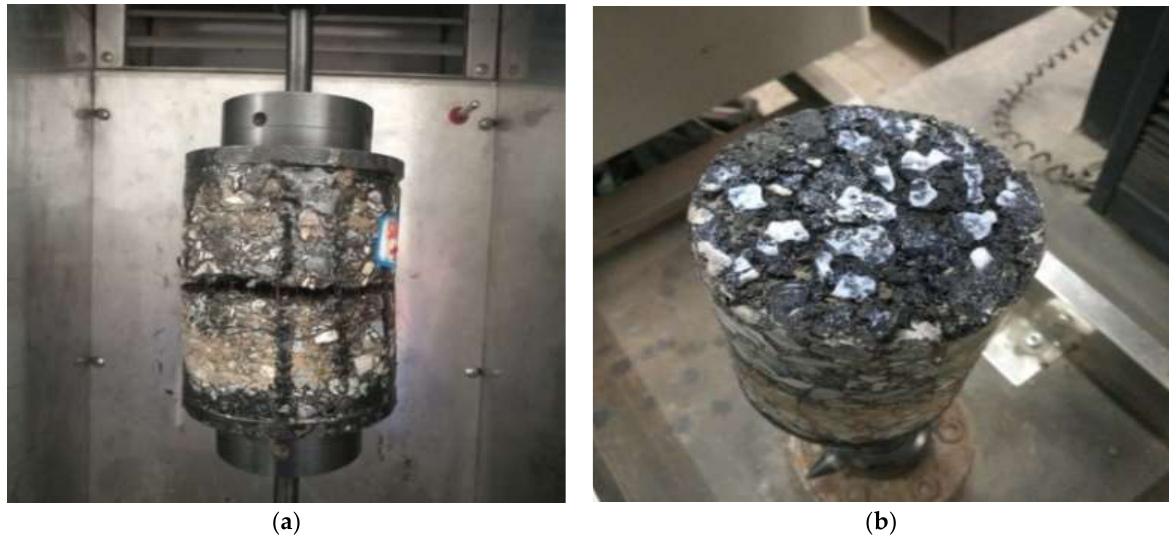
Figure 10. Direct tensile test of the interlayer bond: ( a ) the direct tensile failure; ( b ) the detachment between the drawing head and the specimen.